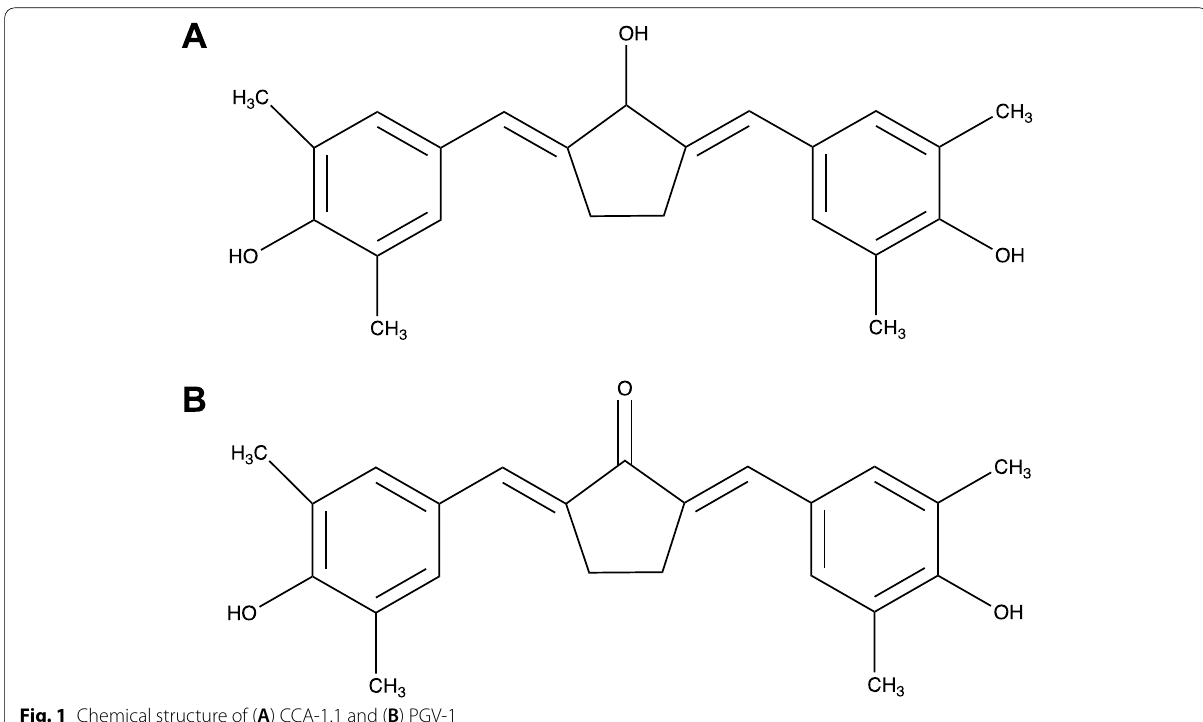
Fig. 1 Chemical structure of ( A ) CCA‑1.1 and ( B )